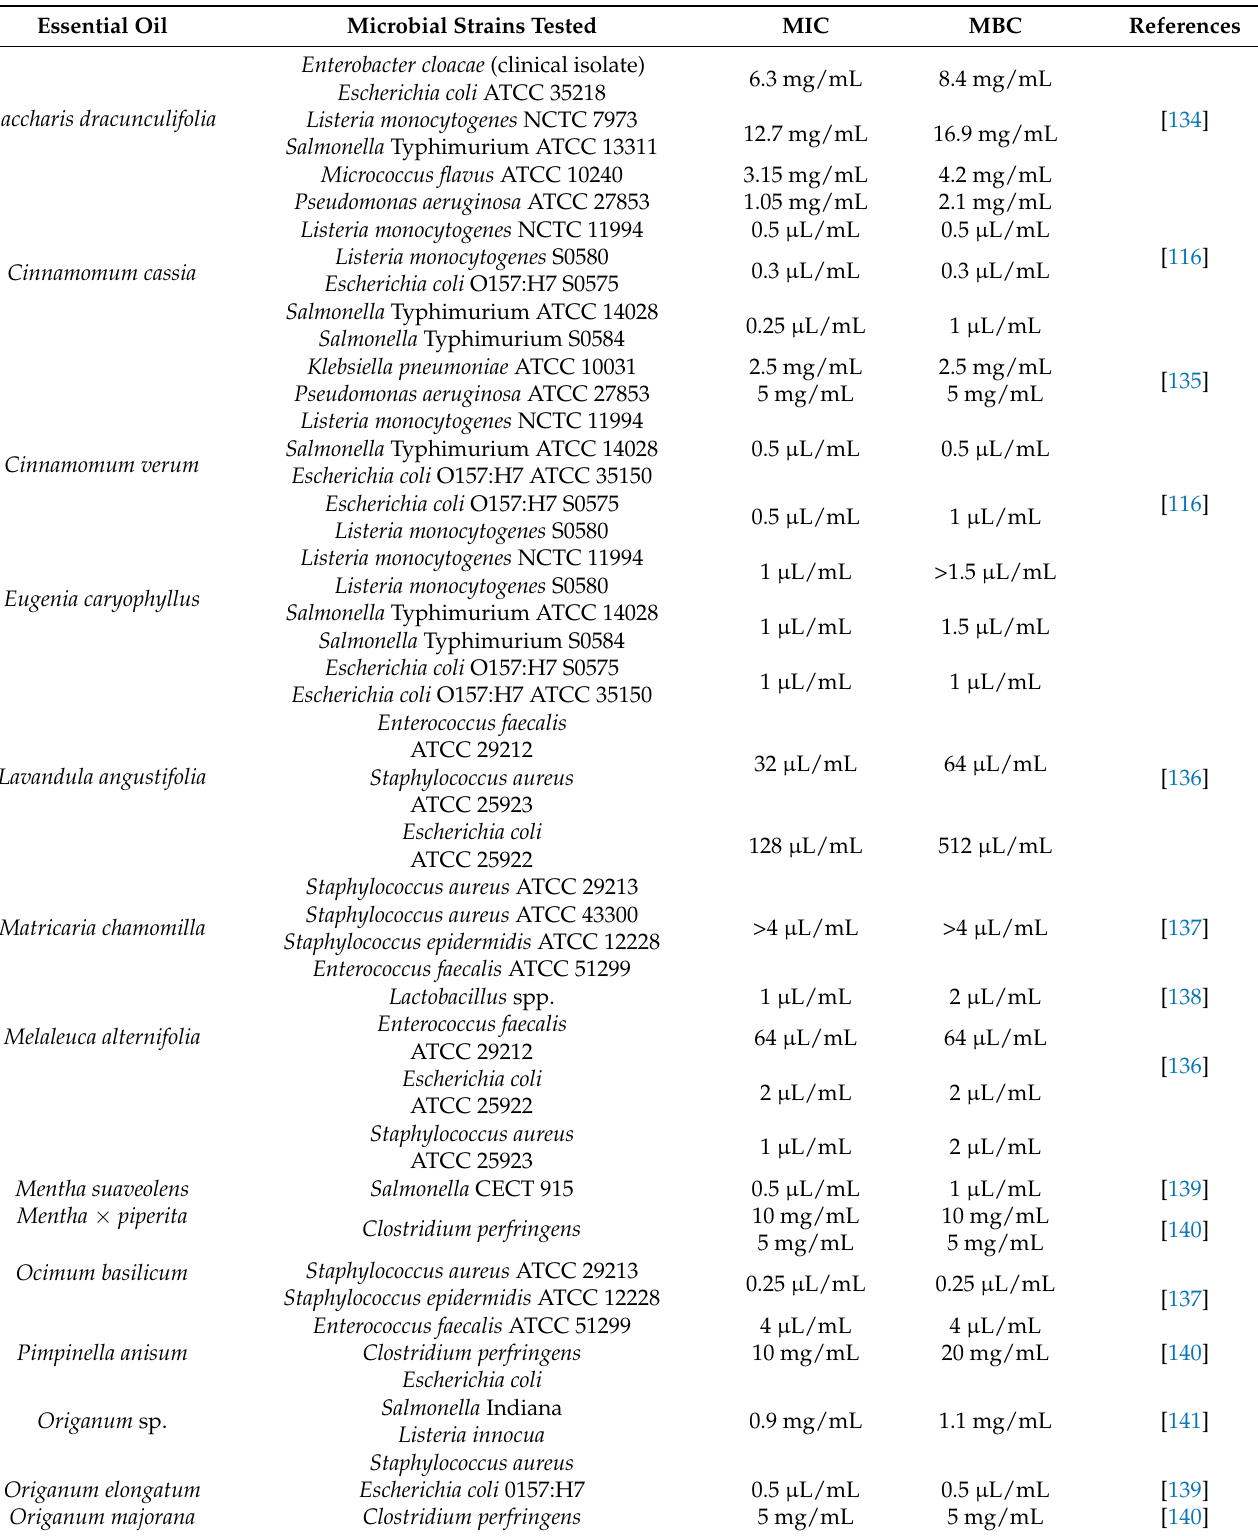
Table 3. Minimal inhibitory concentration (MIC) and minimal bactericidal concentration (MBC) values of essential oils against foodborne pathogens found in the